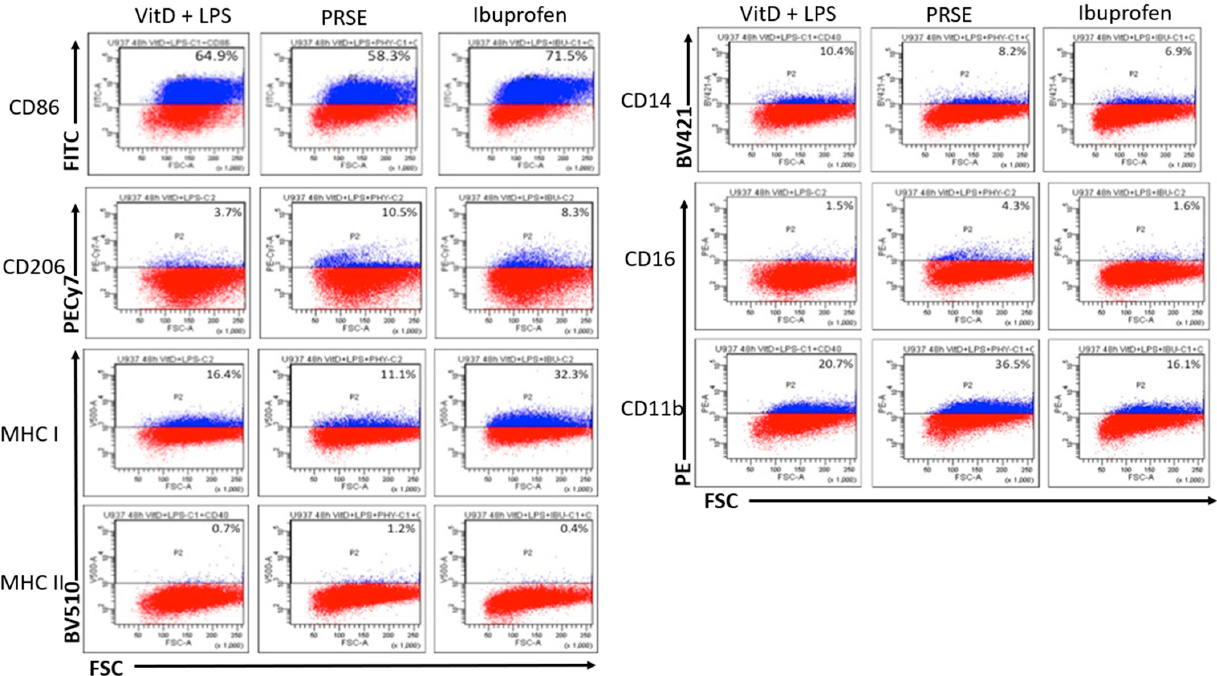
Figure 1. Expression of cell surface markers after 24 h of incubation by flow cytometry: PE, phycoerythrin; AF, Alexa Fluor; PE-Cy7, phycoerythrin-cyanine 7; BV, Brilliant Violet.